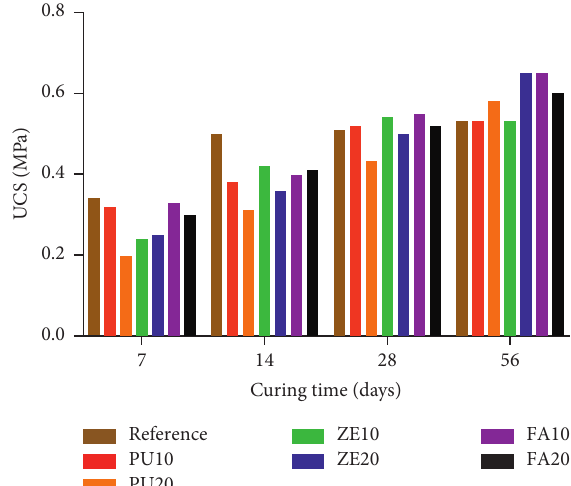
Figure 8: Mean unconfined compressive strength (UCS) for backfill samples prepared without (reference) and with 10 and 20% fly ash (FA), pumice (PU), and zeolite (ZE). See Table 6, for mixture designs.